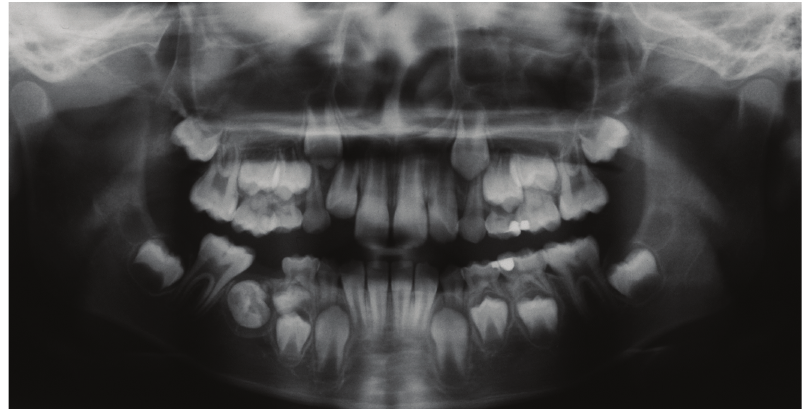
Figure 1: Initial panoramic radiograph: case 1. Complete impaction and mesiolingual inclination of the mandibular right second primary molar in the mandibular bone.